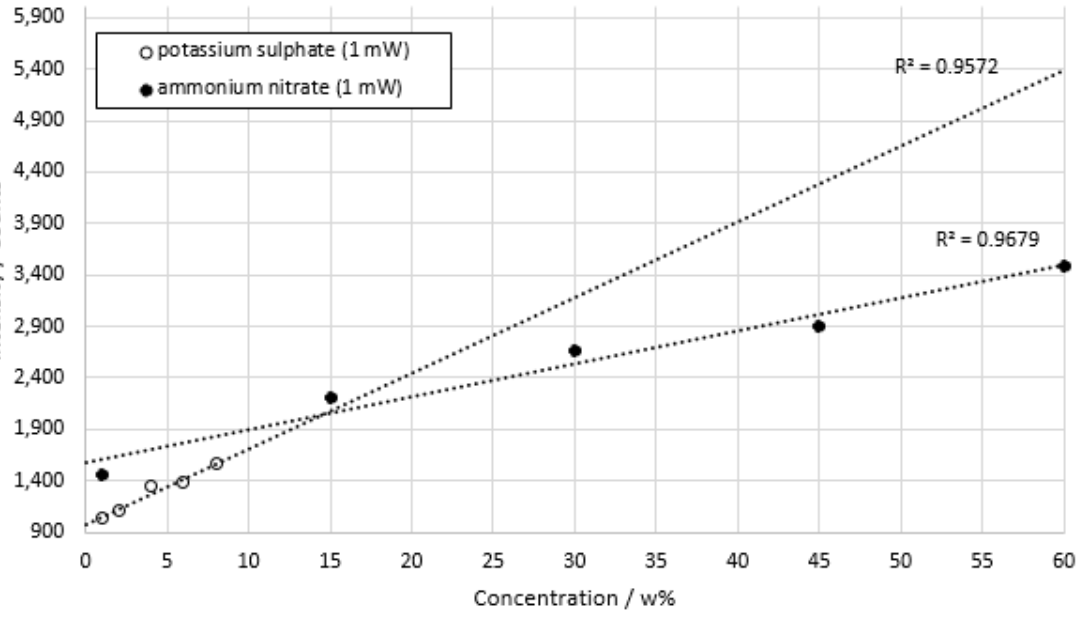
Figure 14. Concentration series of ammonium nitrate and potassium sulphate in deionized water. Integration time 6000 ms. Measuring time per concentration approx. 2 min. Laser power 1 mW.